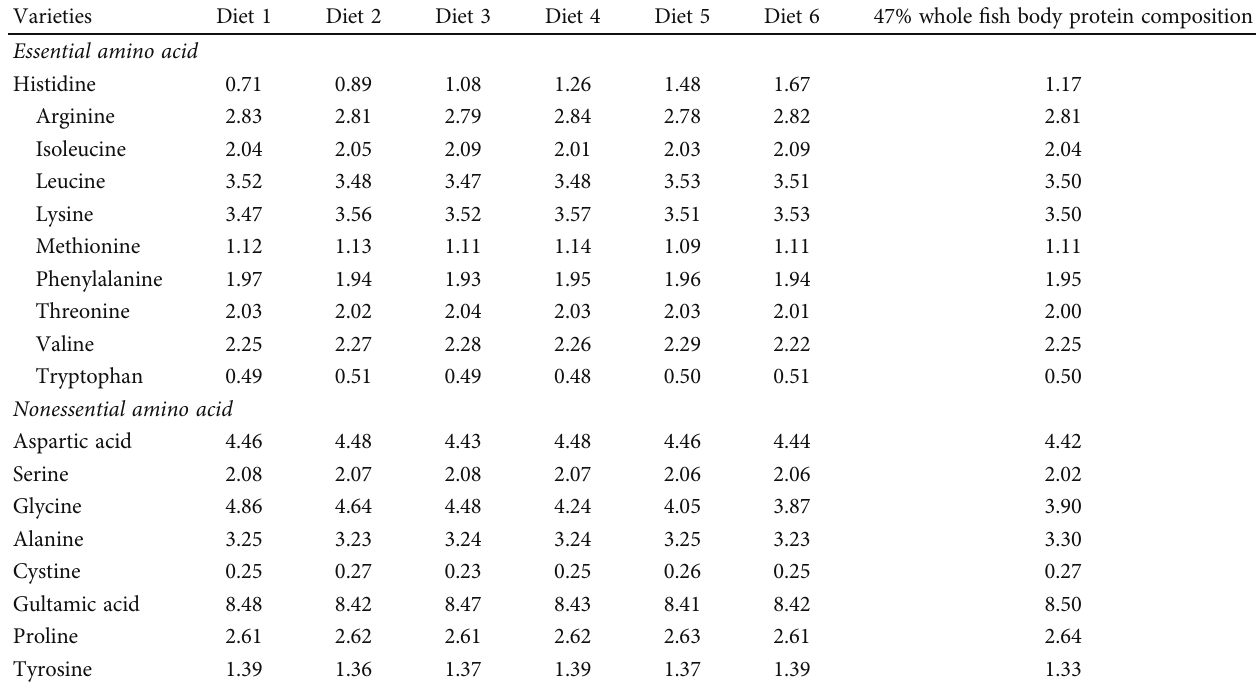
Table 2: Amino acid composition of feed (%, dry matter).